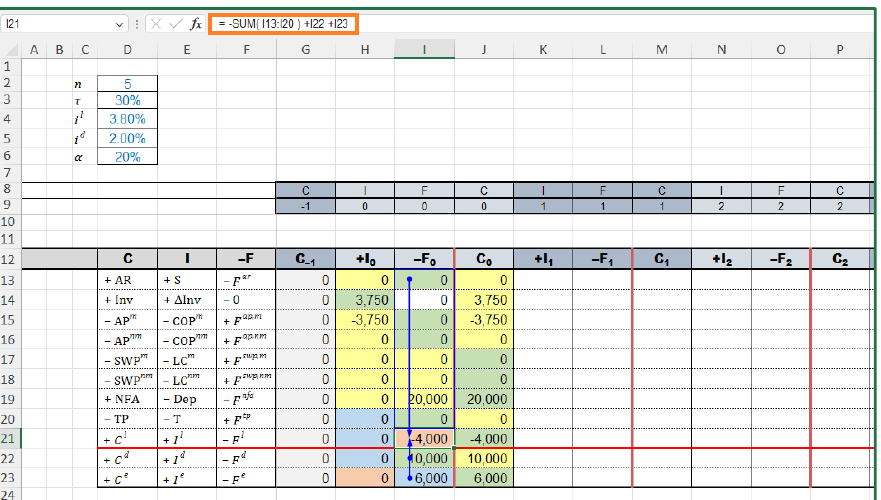
Figure 21. Cell I21 contains the cash flow from/to liquid assets (“SplitScreenStrip” sheet). (The cells whose values are provided in “PreCalc” are in yellow, the cells whose values are calculated with the law of motion are in green, the cells whose values are calculated via suitable formulas are in blue, and the cells whose values are calculated with the law of conservation are in pink orange.)